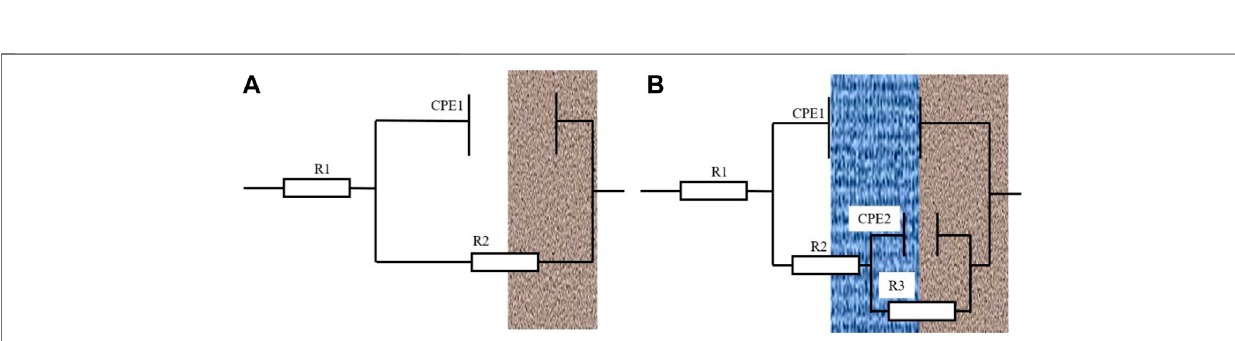
Frontiers in Materials |